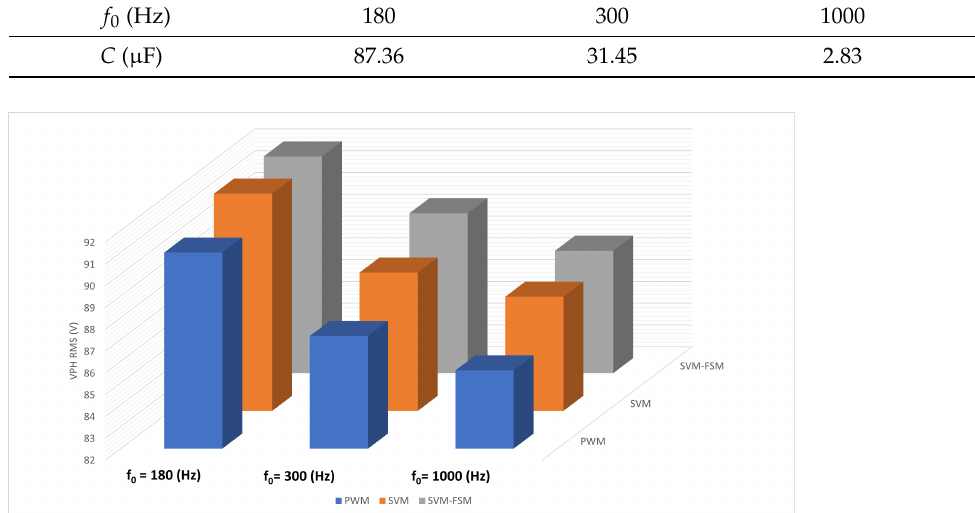
Figure 10. Effective voltage (RMS) depending on the cut-off frequency and modulation